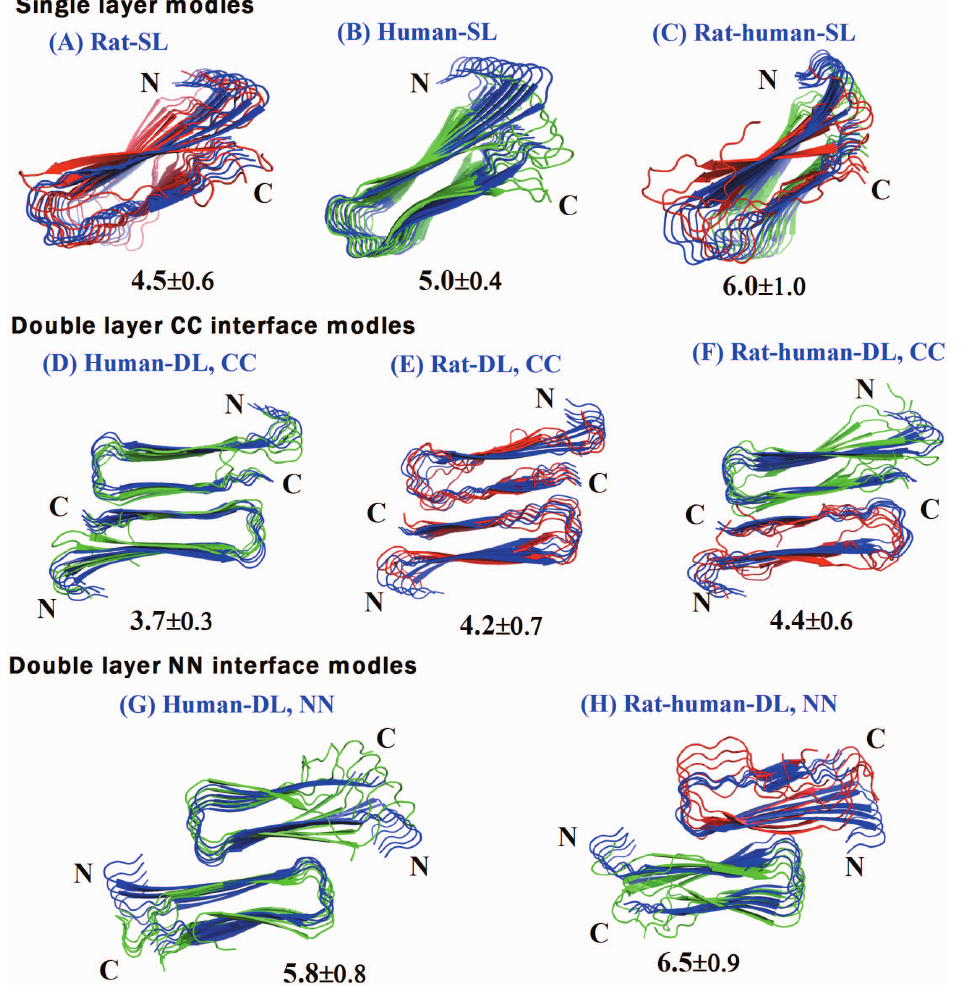
Figure 2. The structural changes in each model, from the trajectory with the largest average root-mean-square-deviations, at the end of 300 ns of molecular dynamics in explicit solvent (water molecules omitted for clarity). A) Single layer conformation of human amylin, (B) single layer conformation of rat amylin, (C) single layer conformation of human-rat complex, (D) Double layer conformation of human amylin with CC interface (E) Double layer conformation of rat amylin with CC interface, (F) Double layer conformation of rat and human amylin mixtures with CC interface, (G) Double layer conformation of rat amylin with NN interface and (H) Double layer conformation of rat–human amylin complex with NN interface. The segments that are colored yellow are the N terminal segments (residue 8–17) and the C terminal segment (residue 28–37). Different colors are applied for the rat (red) and human amylin (green). The initial structures are depicted in blue. Root-mean-square-deviation values calculated for each peptide with respect to the start configurations are included in